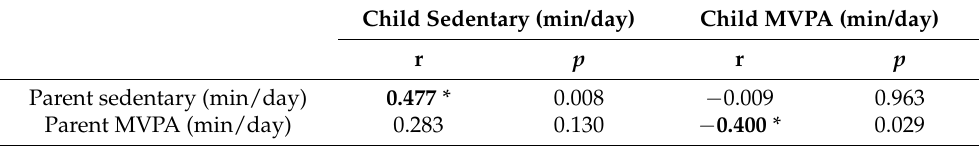
Table 3. Pearson correlation between parents’ and children’s PA and sedentary